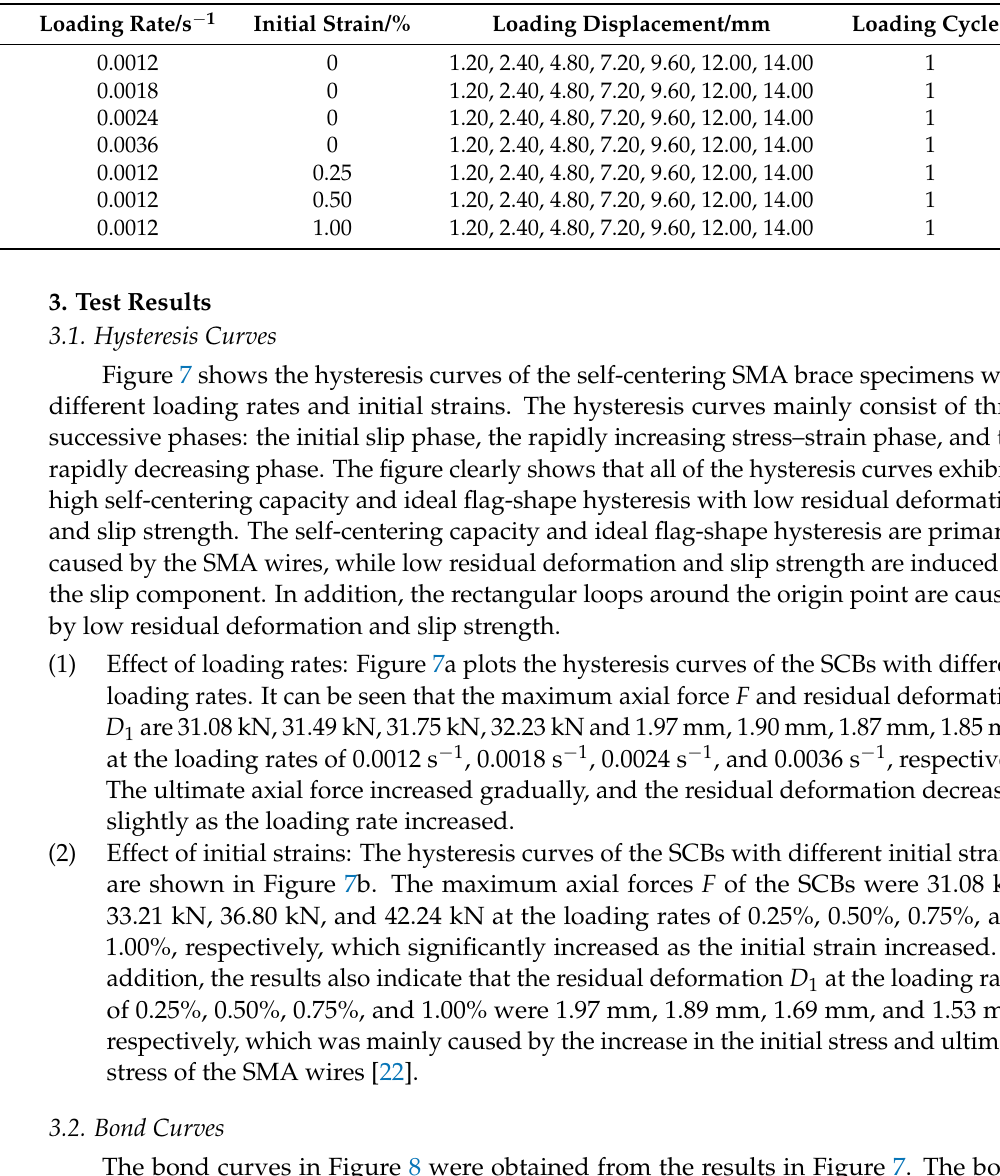
Table 4. Test cases of self-centering SMA brace